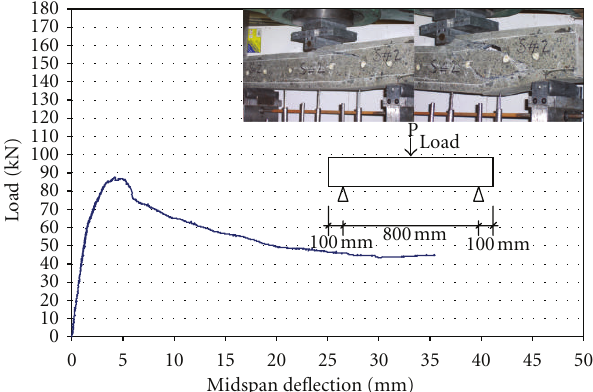
Figure 8: Load versus midspan deflection of control RC beam